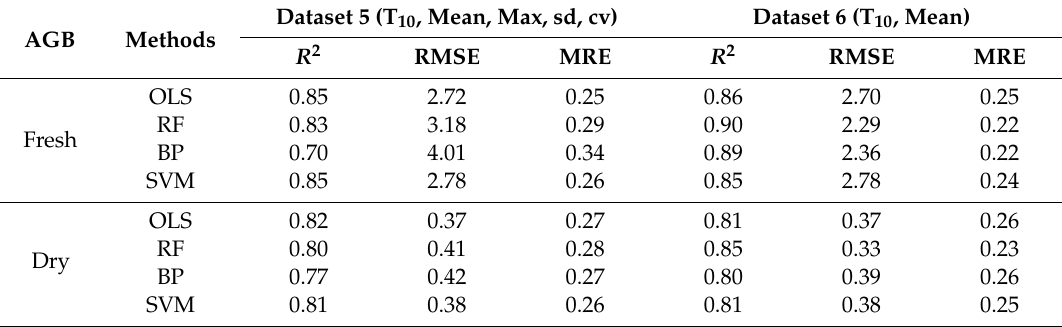
Table 5. R 2 , RMSE, and MRE for linear regression between measured fresh / dry AGB and estimated fresh / dry AGB based on the LiDAR point clouds using four algorithms ( n =